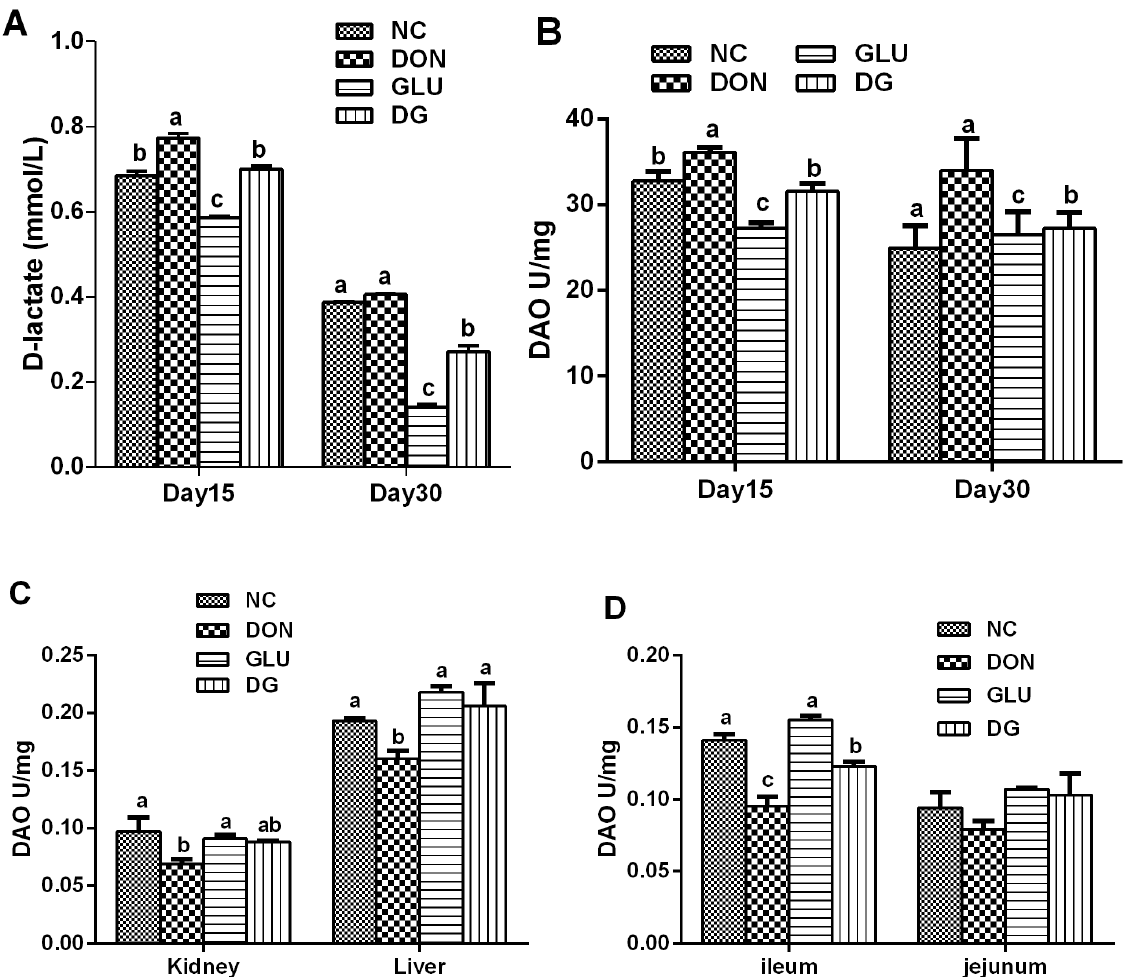
Figure 4. Plasma DAO activity and D-lactate levels in each group. A: Plasma D-lactate levels in each group on day 15 and day 30. B: Plasma DAO activity in each group on day 15 and day 30. C: DAO activity of kidney and liver in each group. D: DAO activity of ileum and jejunum in each group. Dietary treatments were NC, an uncontaminated basal diet, DON, the basal contaminated with 4 mg/kg deoxynivalenol, GLU, uncontaminated basal diet with 2% (g/g) glutamic acid supplementation, and DG, deoxynivalenol-contaminated (4 mg/kg) basal diet with 2% (g/g) glutamic acid supplementation. Data are presented as means 6 SEM, n=7, with a–d used to indicate a statistically significant difference (P , 0.05, one way ANOVA method). DAO: dianine oxidase